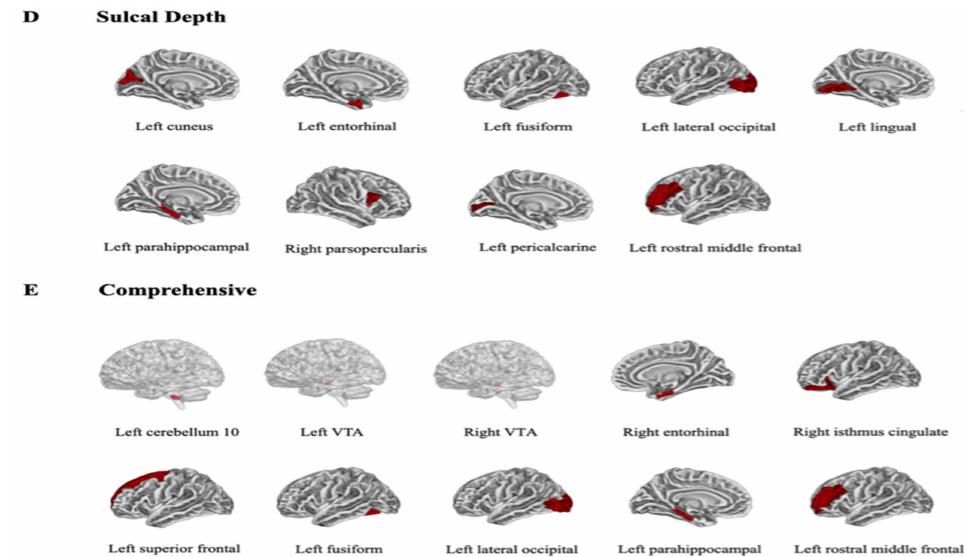
Figure 2. The distribution of the selected brain regions used in constructing the five prediction models. ( A ) the distribution of the gray matter volume; ( B ) the distribution of the cortical thickness; ( C ) the distribution of the gyrification; ( D ) the distribution of the sulcal depth; ( E ) the distribution of the comprehensive variables, including the left cerebellum 10, left VTA, and right VTA in the gray matter volume; right entorhinal is under the cortical thickness; right isthmus cingulate under the gyrification; Left superior frontal, fusiform, lateral occipital, parahippocampal, and rostral middle frontal regions are under the sulcal depth. Abbreviations: VTA, ventral tegmental area.